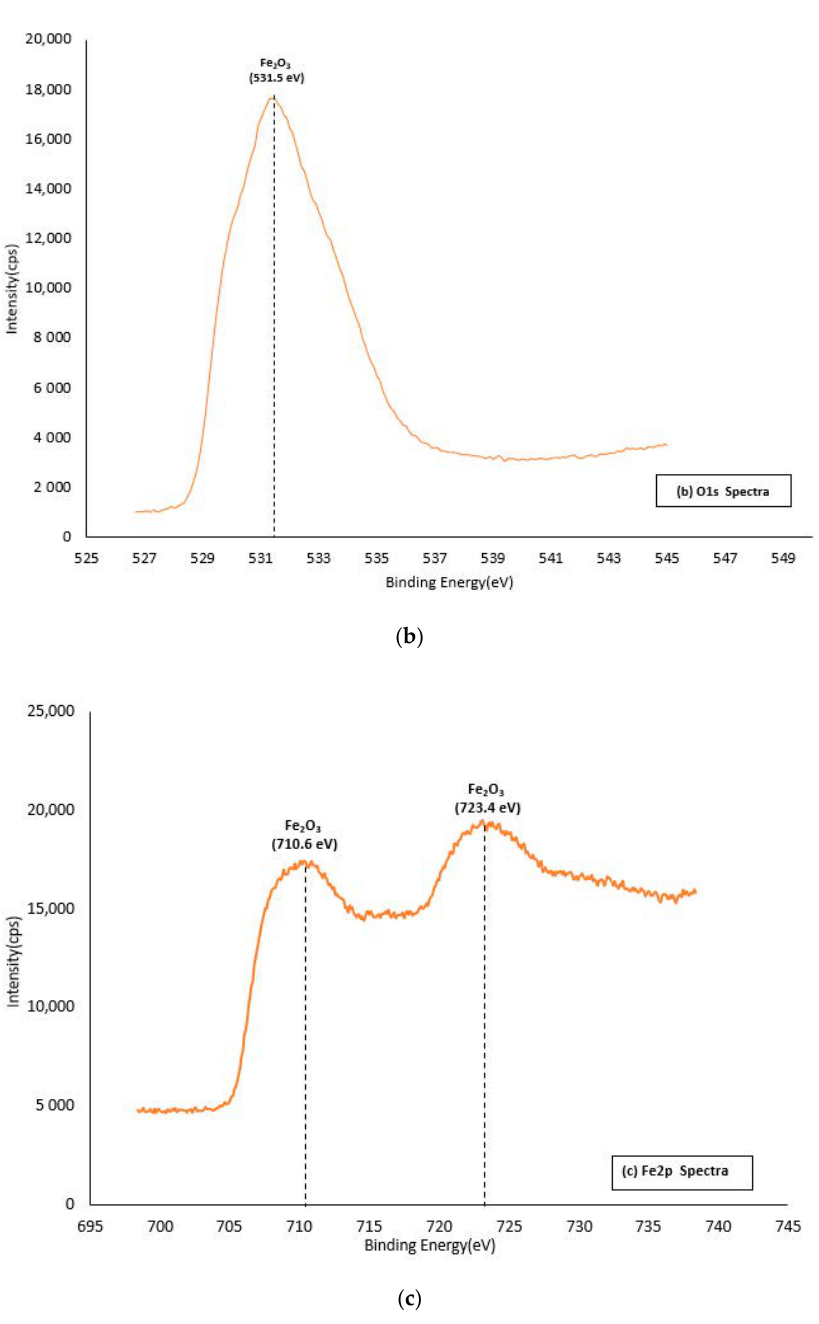
Figure 14. XPS fitting spectra obtained from corrosion product layer at 1000 rpm after 24 h. ( a ) C1s characteristic peak, ( b ) O1s characteristic peak, and ( c ) Fe2p characteristic peak.